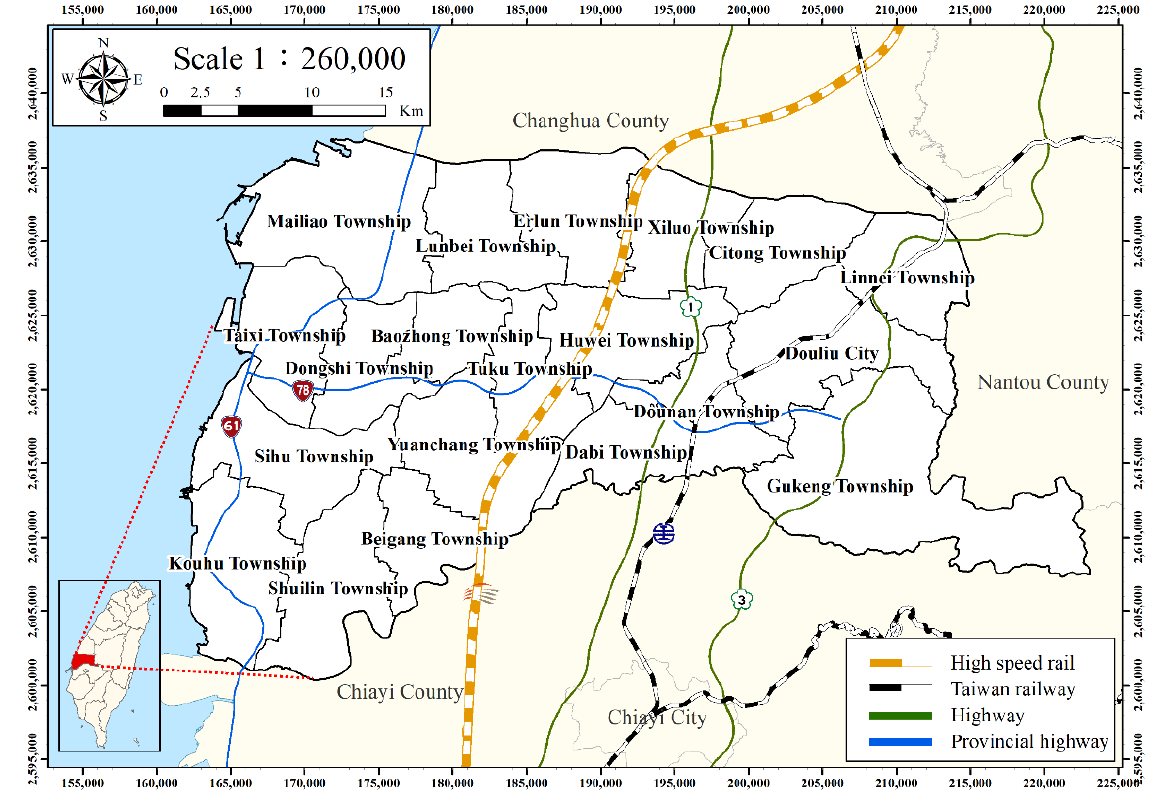
Figure 1. Administration map of Yunlin County, Taiwan. Table 1. The source data used in this study